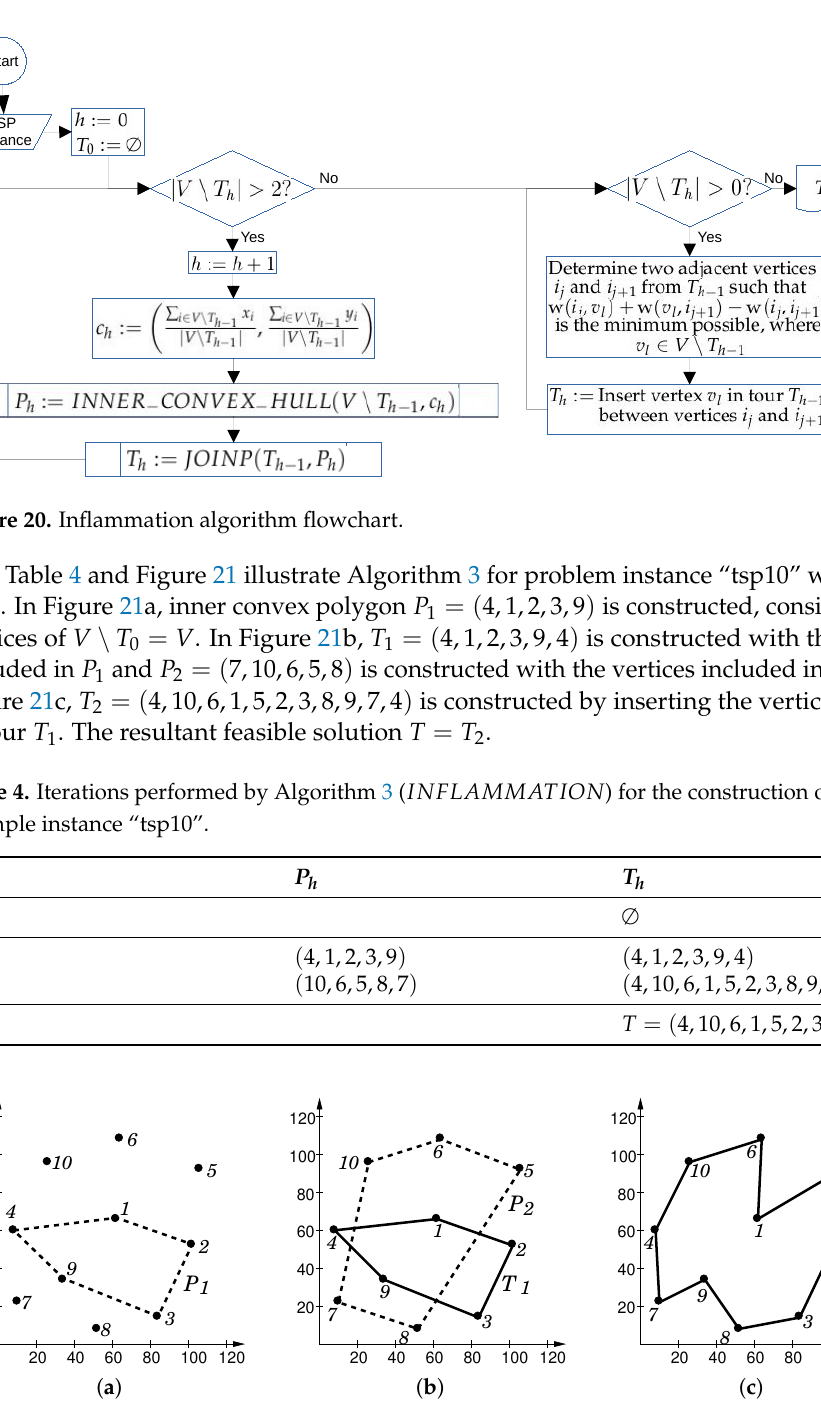
Figure 21. Graphs of the iterations performed by Algorithm 3 ( INFLAMMATION ) to solve the example instance